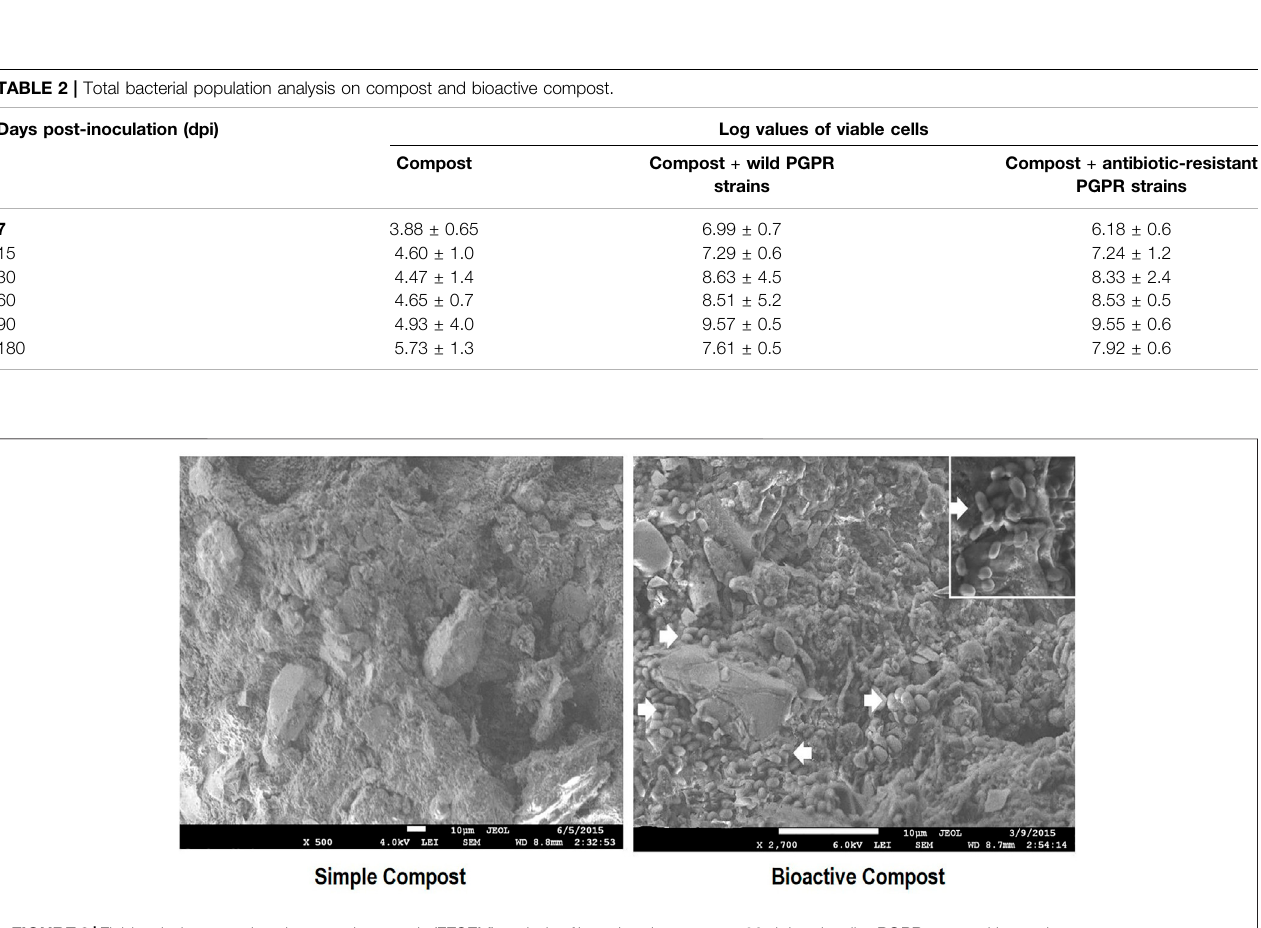
Frontiers in Bioengineering and Biotechnology |